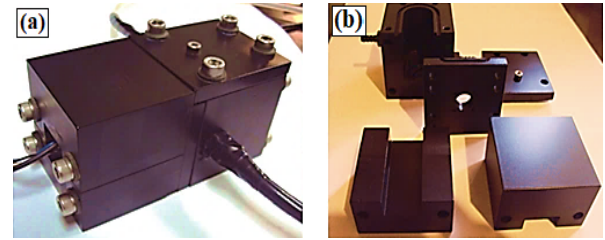
Figure 3. ( a ) Test chamber and ( b ) separated components.